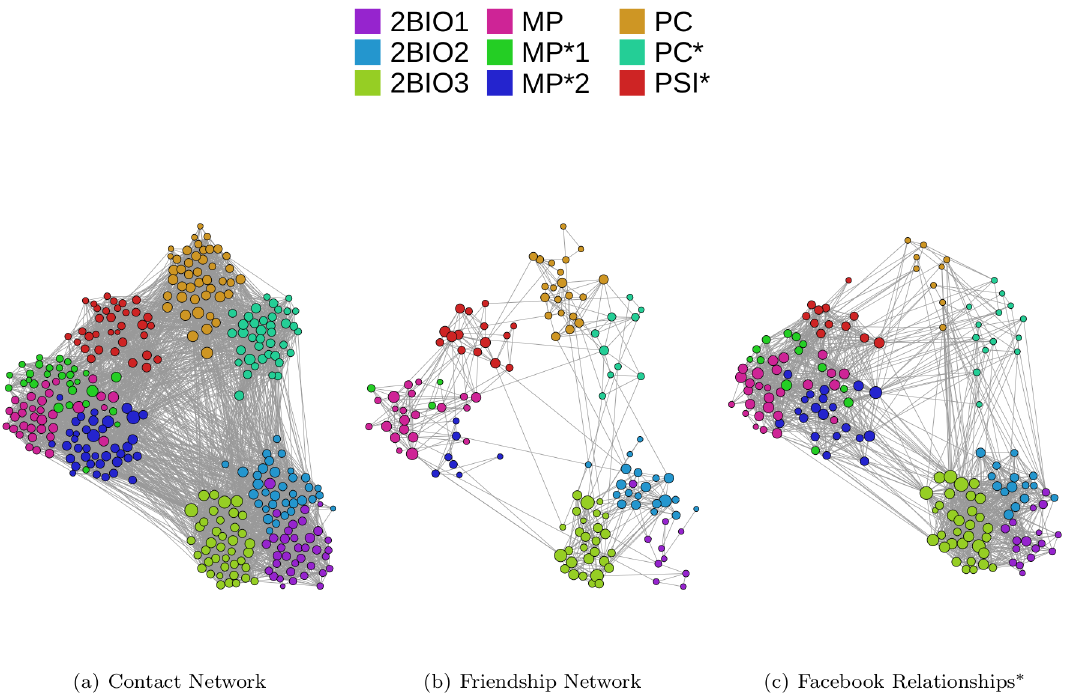
Fig 5. Contact and friendship networks. The three layers of the multiplex are shown using exactly the same layout: each node is placed at the same position in the three panels. The color of each node represents its class and size represents its degree in the corresponding network (here we consider a symmetrized version of the network of reported friendships). * Strictly speaking, the Facebook data do not provide a network as we do not have information about the presence or absence of a link between many pairs of nodes (see Fig 1). Figure created using the Gephi software